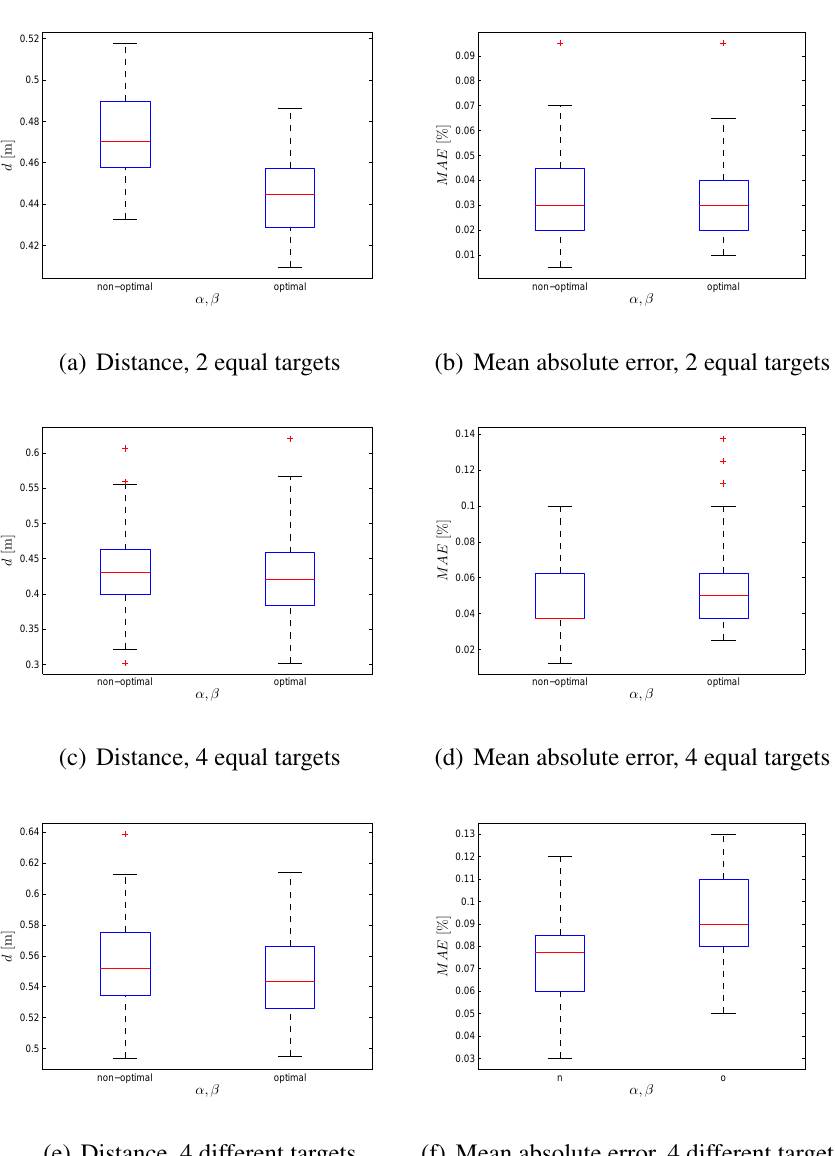
Figure 4. Box-plot comparison of average distance and MAE for 100 robots; (cid:11) = (cid:12) = 1 and (cid:11) = 2 : 65 ; (cid:12) = 2 : 55 . Each box-plot comprises observations ranging from the first to the third quartile. The median is indicated by a horizontal bar, dividing the box into the upper and lower part. The whiskers extend to the farthest data points that are within 1.5 times the interquartile range. Outliers are shown with a plus symbol. The values were obtained from 50